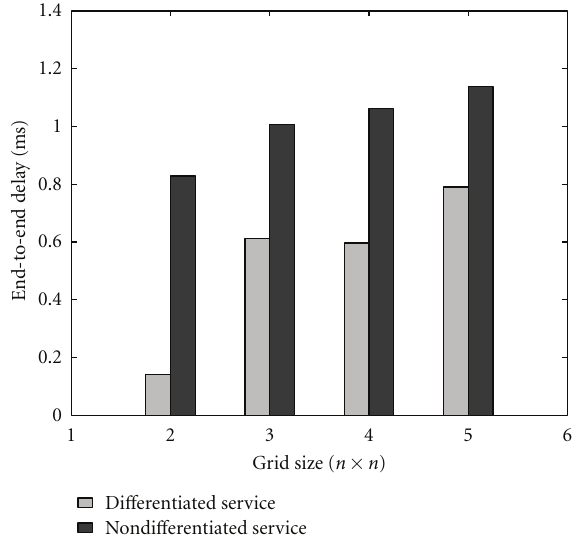
Figure 14: Delay comparison: di ff erentiated and non-di ff erentiated service for best e ff ort service.